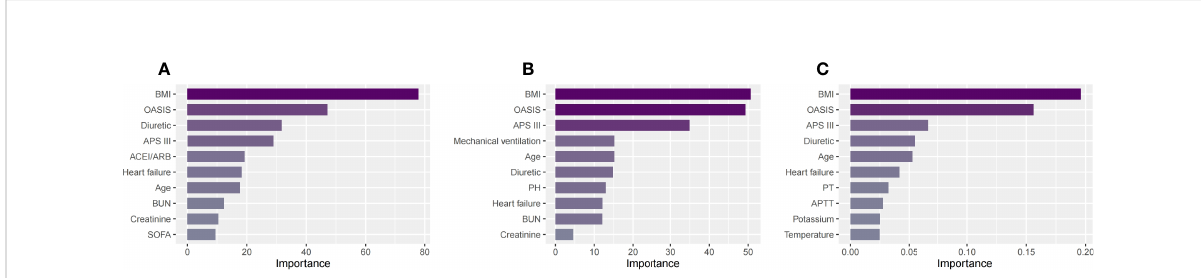
FIGURE 6 The top ten important factors of SA-AKI for women in the decision tree model (A) , random forest model (B) and extreme gradient boosting model (C) . Models were adjusted for all variables, including age, BMI, ethnicity, admission type, hypertension, coronary atherosclerosis, heart failure, diabetes mellitus, COPD, cerebral infarction, chronic liver disease, chronic kidney disease, tumor, APS III, OASIS, SOFA, heart rate, MAP, RR, temperature, SpO2, WBC, hemoglobin, platelet, PH, bicarbonate, BUN, creatinine, potassium, sodium, chloride, glucose, PT, APTT, lactate, vasopressor use, mechanical ventilation use, diuretic, aminoglycoside, statin, ACEI/ARBs. ACEI/ARBs, Angiotensin-converting enzyme inhibitors/ angiotensin receptor blockers; AKI, Acute kidney injury; APS III, Acute Physiology Score III; APTT, Activated partial thromboplastin time; BMI, Body mass index; BUN, Blood urea nitrogen; COPD, Chronic obstructive pulmonary disease; OASIS, Oxford Acute Severity of Illness Score; PT, Prothrombin time; SA-AKI, Sepsis associated acute kidney injury; SOFA, Sequential Organ Failure Assessment; RR, Respiratory rate; WBC, White blood cell.